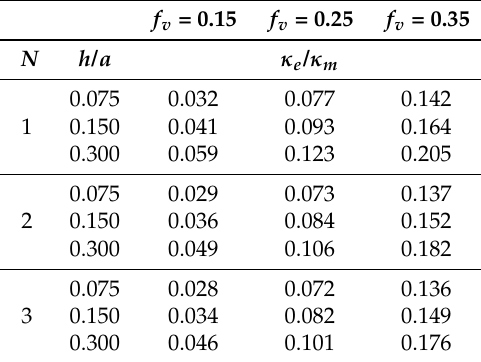
Table 1. Relative effective conductivity κ e / κ m obtained by full numerical calculations for woodpile structures composed of N = 1, 2, and 3 layers and for three values of f v . For each structure, three values of the height h of the bars were considered. The conductivity κ f of the fluid has been set to zero. The step size of the discretization grid along z was kept the same for all calculations; the mesh used for the thicker slab ( h / a = 0.3 and N = 3) was 100 × 100 × 361. f v =